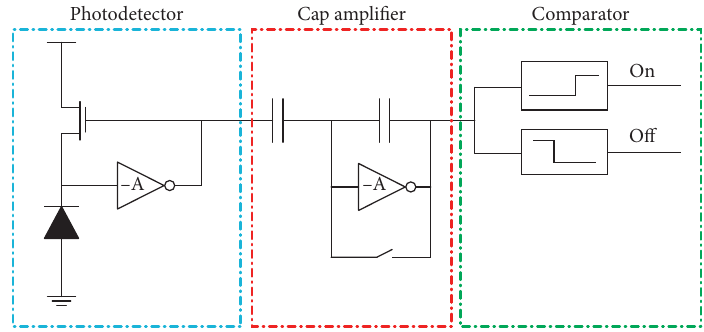
Figure 1: Schematic diagram of the pixel structure of the dynamic vision sensor. Photodetector is used for photocurrent-voltage logarithmic conversion, cap amplifier is used to amplify voltage changes, and comparator is used for threshold